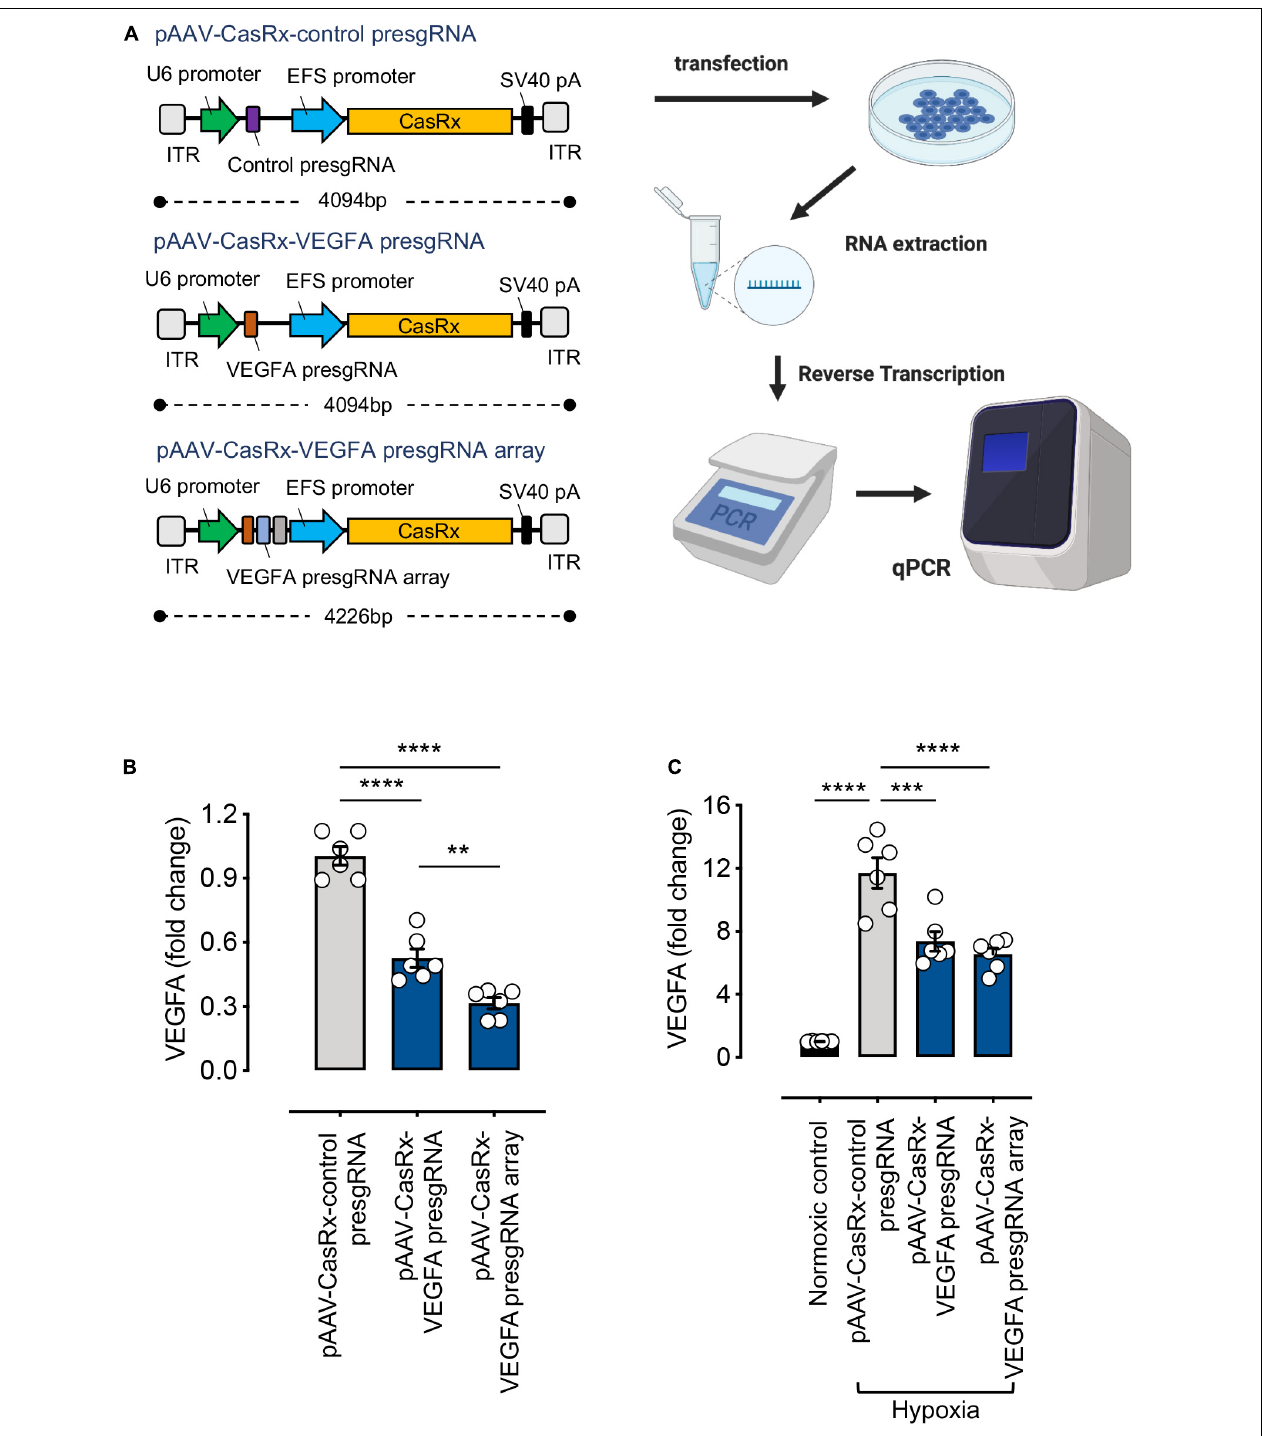
FIGURE 3 | RNA-editing efficiency of the CRISPR/CasRx system using the all-in-one pAAV construct. (A) Illustration of the all-in-one pAAV constructs and the experimental procedure. Created with BioRender.com. (B) HEK293FT cells were transfected with pAAV–CasRx–control pre-sgRNA, pAAV–CasRx–VEGFA pre-sgRNA, and pAAV–CasRx–VEGFA pre-sgRNA array for 72 h. The VEGFA mRNA level was determined by quantitative PCR (qPCR) as described in section “METHODS” ( n = 6). (C) Human Müller cells (MIO-M1) were transfected with pAAV–CasRx–control pre-sgRNA, pAAV–CasRx–VEGFA pre-sgRNA, and pAAV–CasRx–VEGFA pre-sgRNA array for 48 h and under hypoxia condition for another 24 h. The VEGFA mRNA level was determined by qPCR as described in section “METHODS” ( n = 6). Data are expressed as the mean ± SEM. Statistical analysis was performed with GraphPad Prism 7 (GraphPad, San Diego, CA, United States) and undertaken with one-way ANOVA and Tukey’s multiple comparison test. ** P < 0.01, *** P < 0.001, **** P < 0.0001.